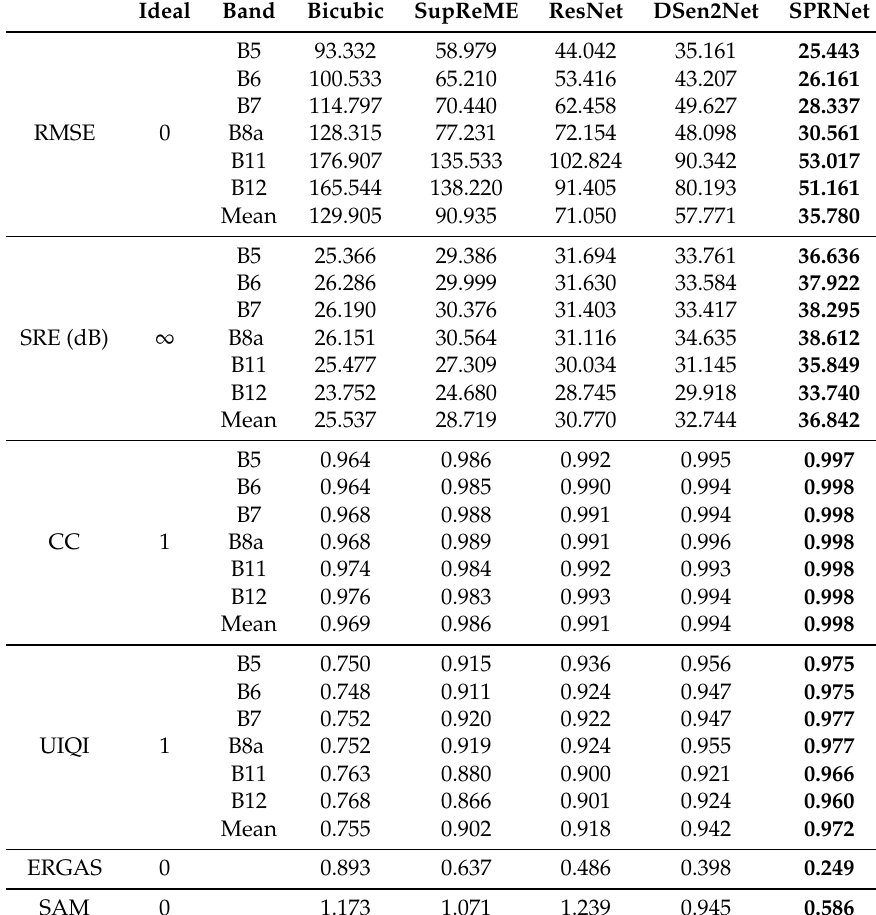
Table 3. Quantitative assessment of the SPRNet 2 Bold indicates the best